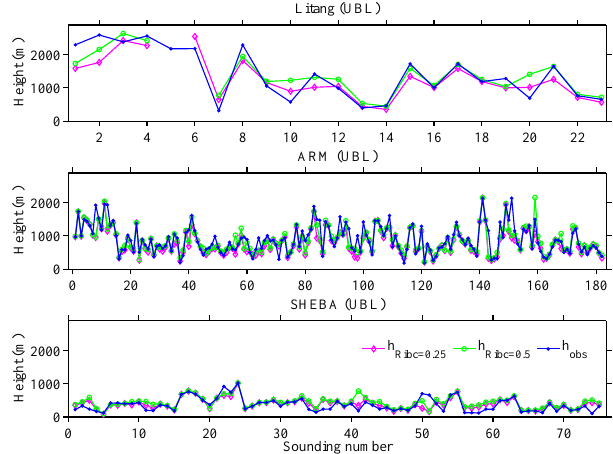
Figure 7. Comparisons of the heights of UBL at different sites de- termined by the bulk Richardson number method with Ri bc = 0 . 25 (diamond) and 0.5 (circle), and the observed PBLHs